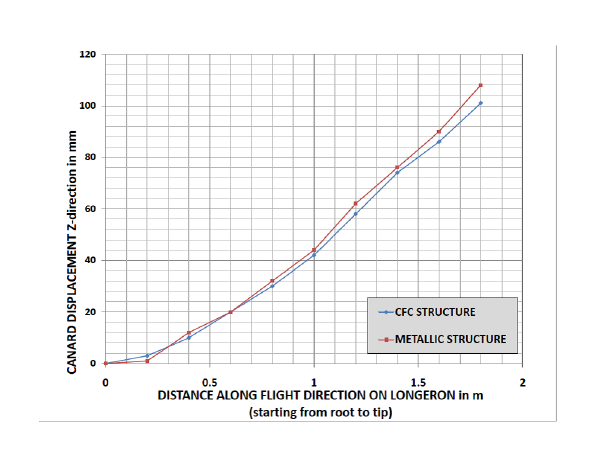
Figure 7: Vertical Deflection on Axis of